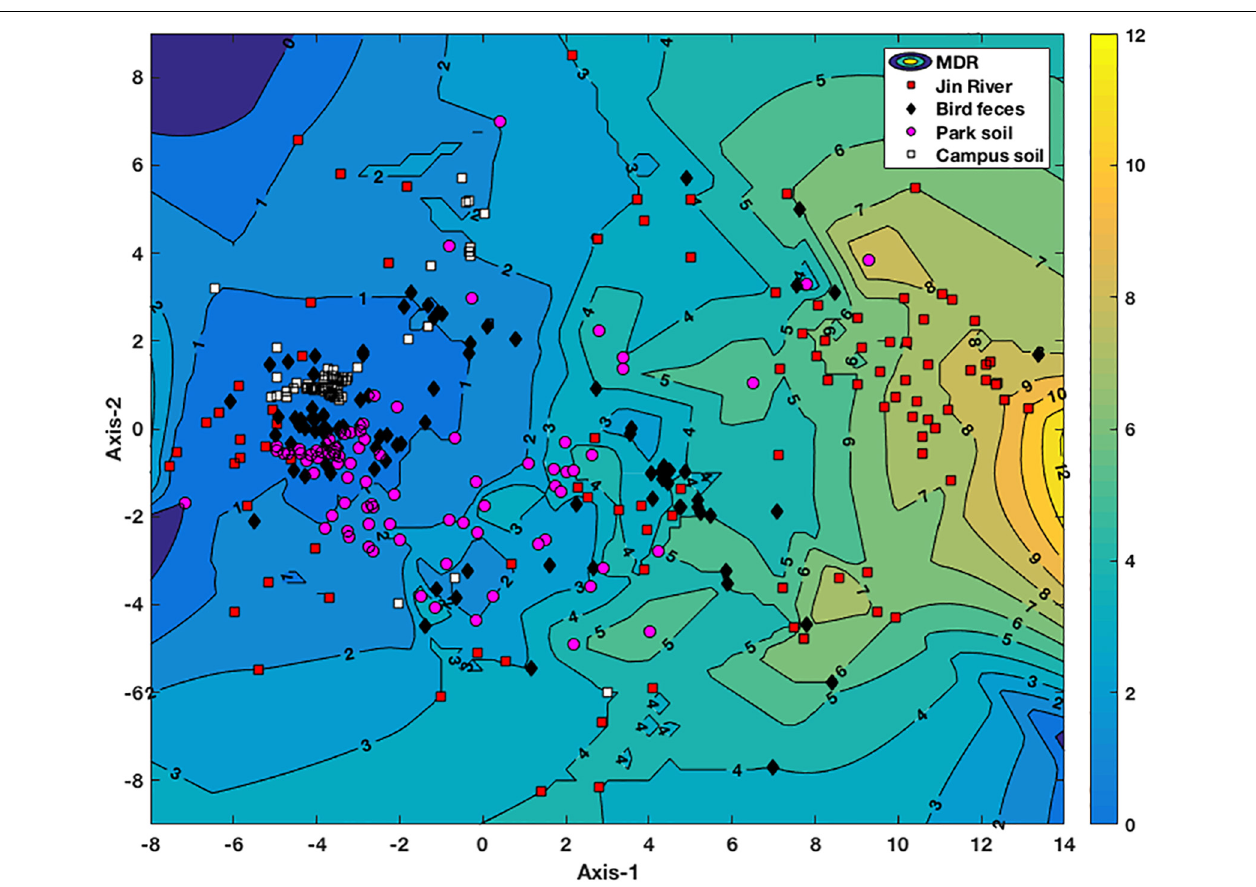
FIGURE 4 | NMDS analysis of antibiotic resistance pattern of the E. coli isolates based on their antibiotic MIC data. The Kruskal stress is 0.1273. A contour map of multidrug resistance (MDR) of the E. coli isolates is generated via interpolating the MDR data of these strains and lined behind the NMDS plot. The numbers on the contour lines are the numbers of antibiotics that one strain is resistant to. The degree of the MDR is indicated by a color bar with warm color (yellow) representing high level of MDR and cool color (blue) for low MDR